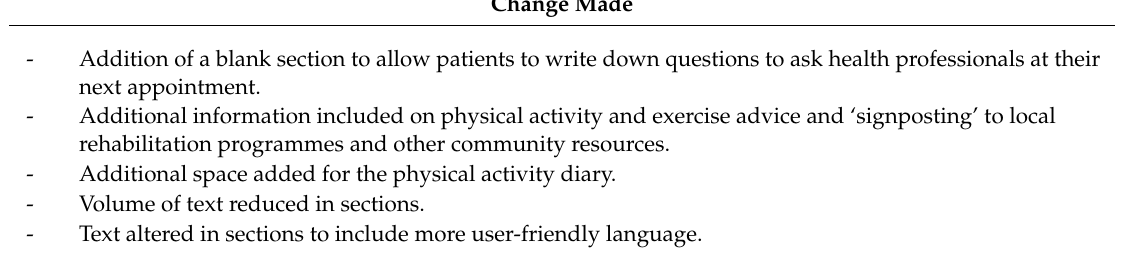
Table 3. Key changes to the “The Healthy Brain Rehabilitation Manual” based on qualitative